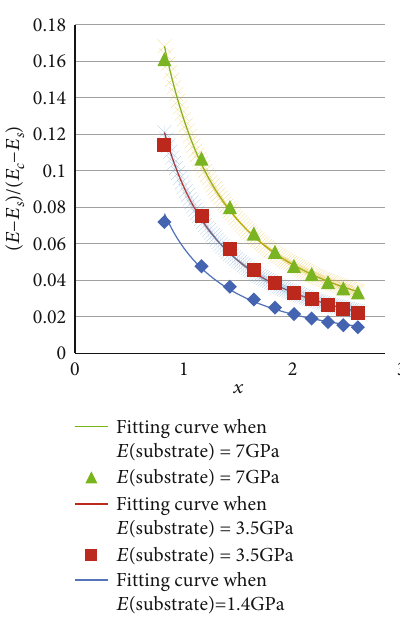
Figure 6: Fit E (composite) by Equation (14), when E (substrate) varies between 1.4GPa and 7GPa. Table 1: Results of the fi tting parameters for Equation (14)